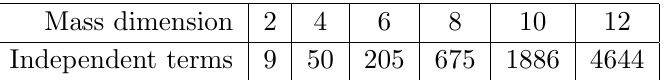
Table 1 . Number of independent terms in an ansatz for six-momentum con(cid:12)gurations with all zero phase weights as a function of the mass